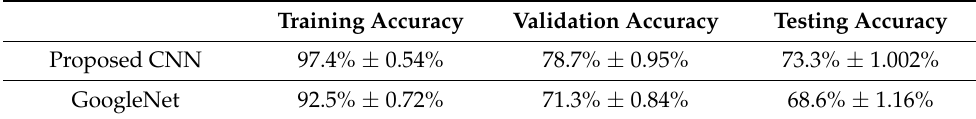
Table 6. Learning Training, Validation, Testing Accuracy result by material.